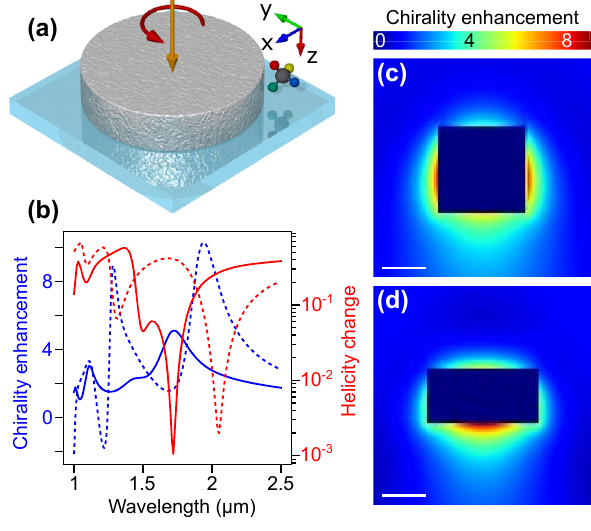
Figure 1: Calculation of optical chirality enhancement for a model HID nanodisk. (a) Schematic representation of the studied system. High index ( n = 4 to mimic silicon) dielectric nanodisk is used to enhance the optical chirality density at molecule location. The system is illuminated by a left-handed circularly polarized light and embedded in water ( n = 1.33). (b) Comparison of helicity change and chirality enhancement spectra for the two disks with varying AR. Solid lines:  = 0 . 5, dashed lines:  = 1. Chirality enhancement is averaged over a spherical surface with radius 50 nm larger than that of a disk. For the disk with  = 0 . 5 maximal enhancement is matched with helicity change minimum, while for  = 1 the two are significantly shifted with respect to each other. Maximum surface averaged enhancement for the disk with  = 1 is larger than for the disk with  = 0 . 5, yet it corresponds to large helicity change on the order of 10%. Spatial maps of chirality enhancements for nanodisks with ARs (c)  = 1 and (d)  = 0 . 5 (the scale bars are 200 nm long). Note how,  = 0 . 5 leads to enhancement predominantly along the z -axis below the particle, while when  = 1 chirality is enhanced preferentially around the middle